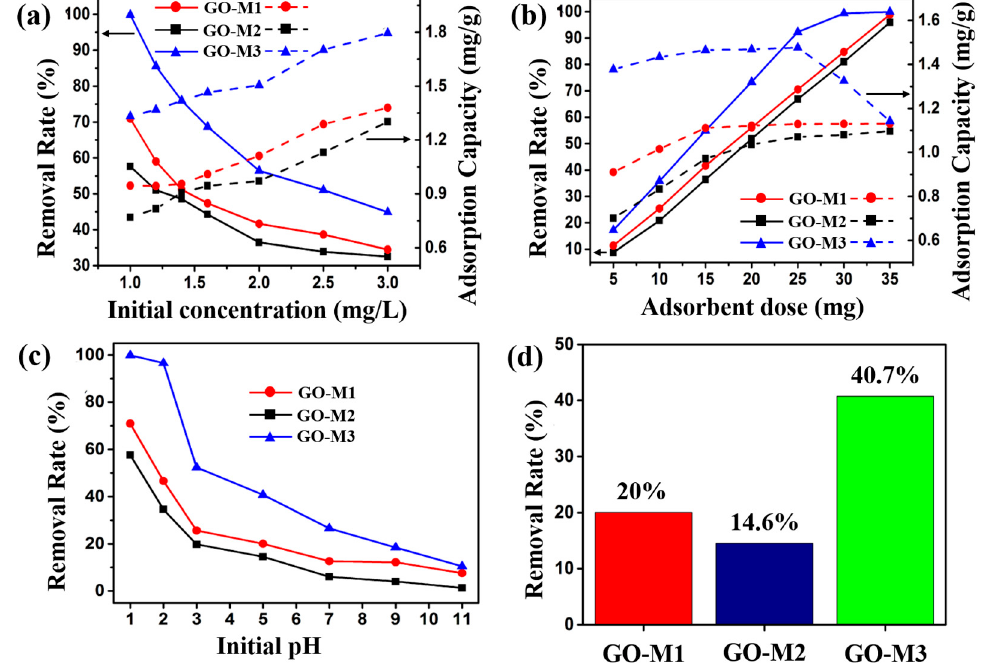
Figure 6. Effect of initial concentration ( a ), adsorbent dose ( b ) and initial pH ( c ) on the adsorption of Cr(VI) by GOs. ( d ) Comparison of the removal of Cr(VI) by GOs at pH = 5 (reaction conditions: the dosage of adsorbent was 15 mg, the initial concentration of Cr(VI) solution was 1 mg/L, the solution volume was 20 mL and the adsorption was carried out at 298.15 K for 30 min).